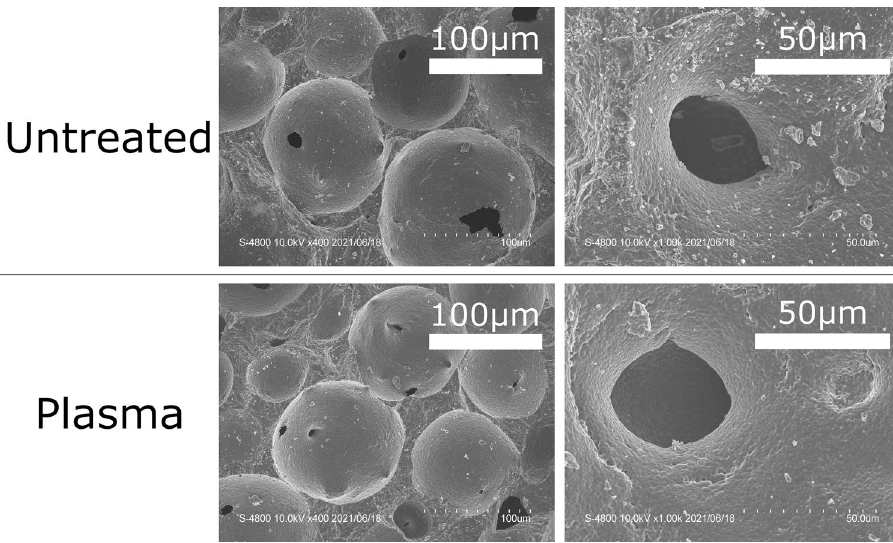
Figure 2. SEM images of the outer surfaces of untreated (top) and plasma-treated (bottom) porous β-TCP disks. Low magnification = × 400 (left). High magnification = × 1000